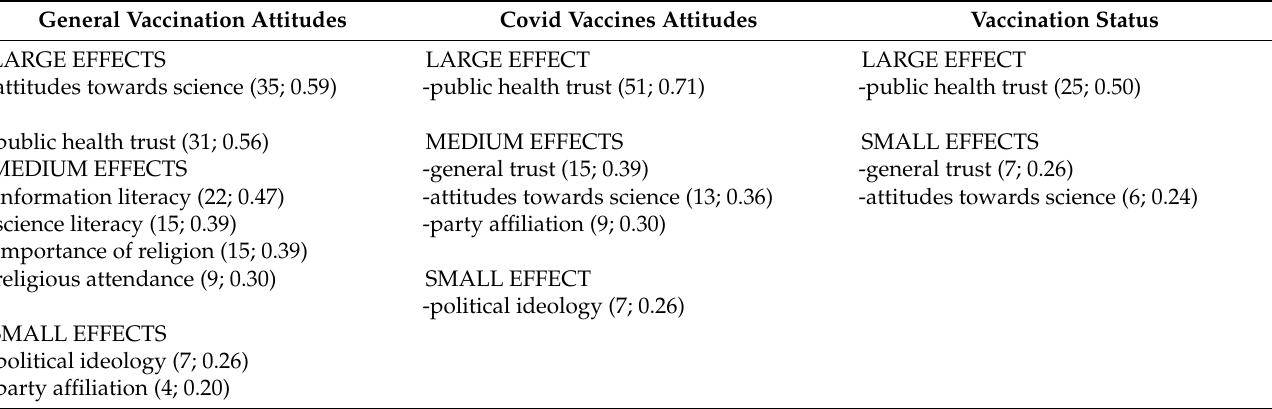
Table 6. Effect-size ranked significant single predictors (%variance explained; Pearson’s